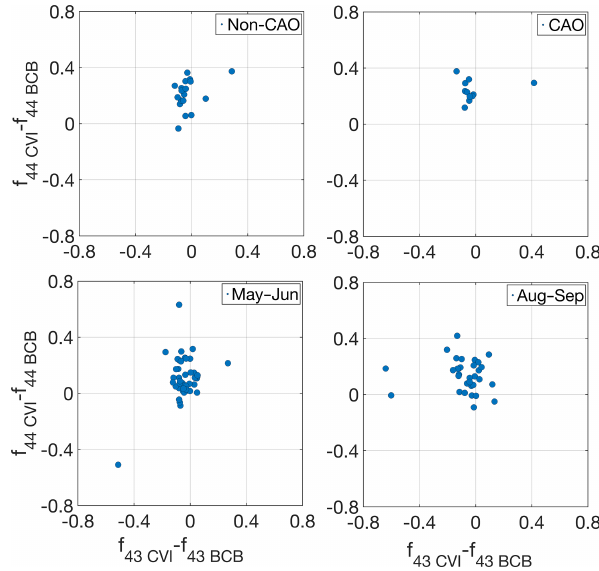
Figure 7. Scatterplot of the difference in f 44 in cloud legs with CVI data and below cloud base (BCB) legs for an individual cloud ensemble relative to the analogous difference for f 43 . Panels rep- resent different seasons with winter deployments (January–March) separated into CAO and non-CAO days.